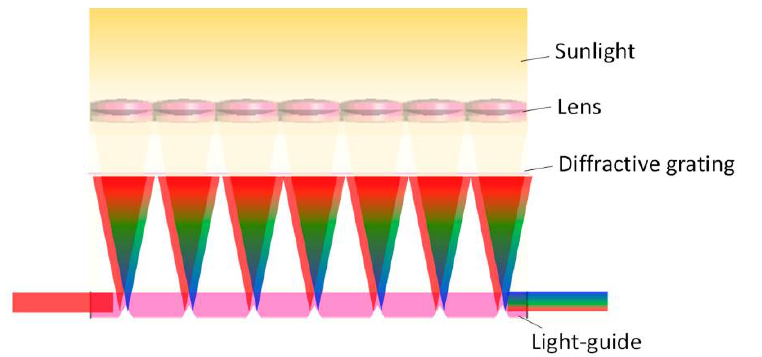
Figure 3. Spectral-beam splitting scheme in side absorption concentrated modules. Reproduced from [65], Table 1. Diffractive and spectral beam splitters (SBS) techniques. Reproduced from [65], mdpi:2020. Category